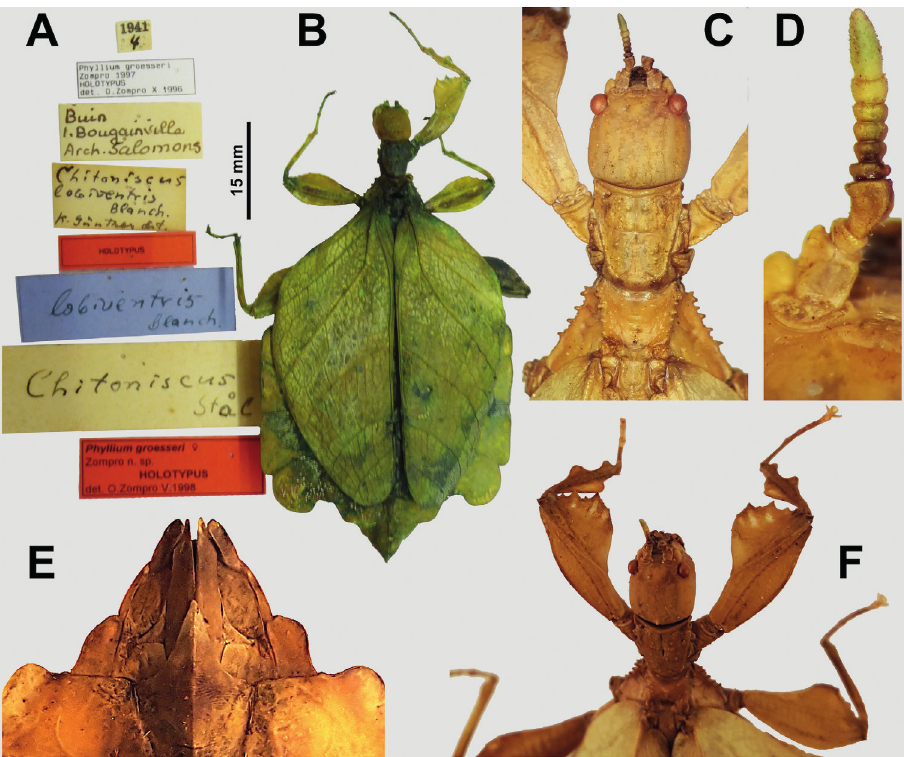
Figure 10. Vaabonbonphyllium groesseri comb. nov. females A data labels associated with the holotype B holotype, habitus, dorsal C details of head through thorax, dorsal D details of antennae, dorsal E details of genitalia, ventral F front legs, head, and thorax, anterodorsal. Scale bar associated with A and B . A and B photographs by Christian Schmidt (SMTD), other images taken by the first author of specimens from the